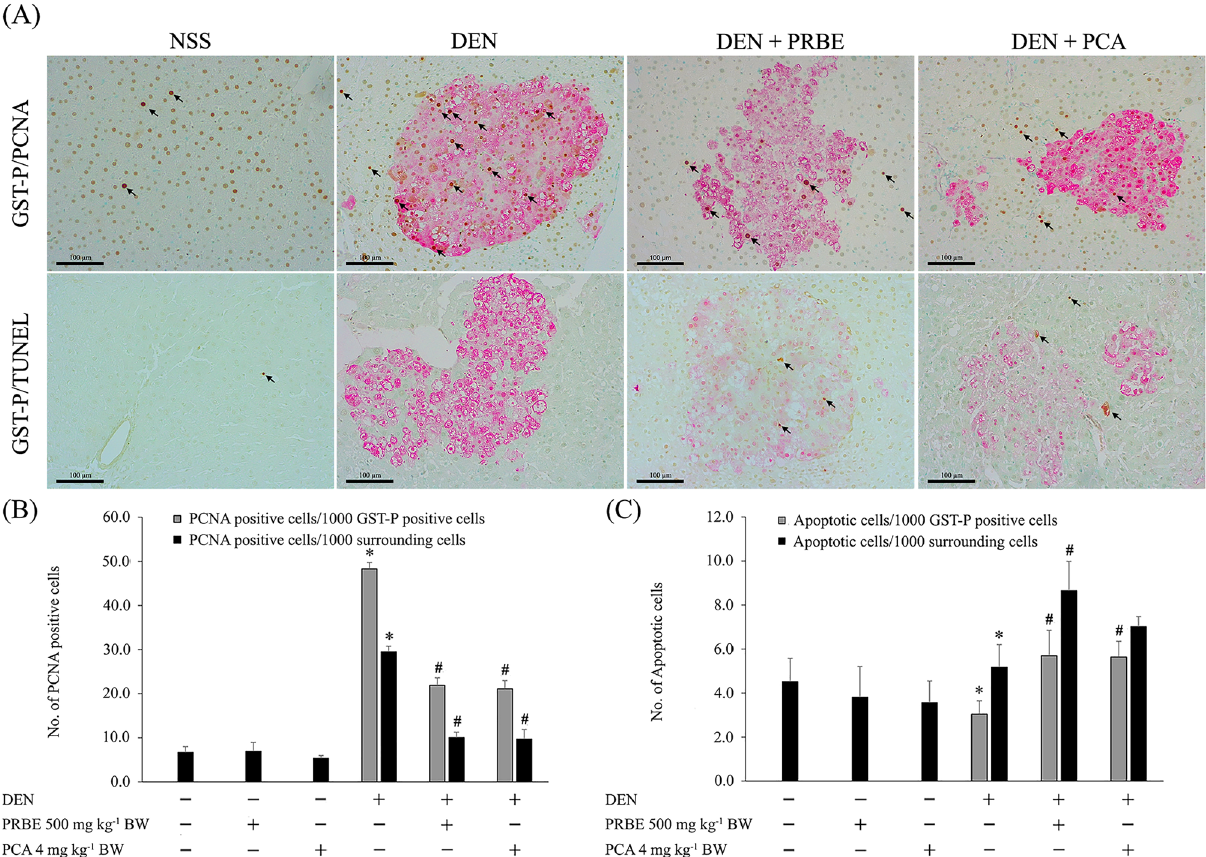
Figure 4. Effect of purple rice bran extract and protocatechuic acid on cell proliferation and apoptosis (15- week protocol). Arrowheads indicate stained hepatocytes. ( A ) Representative double immunohistochemical staining of GST-P (red)/PCNA (brown) and GST-P (red)/apoptosis (TUNEL) (black) in the liver of control and experimental animals (20 ×); ( B ) number of PCNA-labeled cells per 1000 hepatocytes; ( C ) number of apoptotic cells per 1000 hepatocytes. Values are expressed as mean ± SEM. *Significantly different from the negative control group, p < 0.05. # Significantly different from the positive control group, p < 0.05. DEN: diethylnitrosamine, PCA: protocatechuic acid, PRBE: purple rice bran